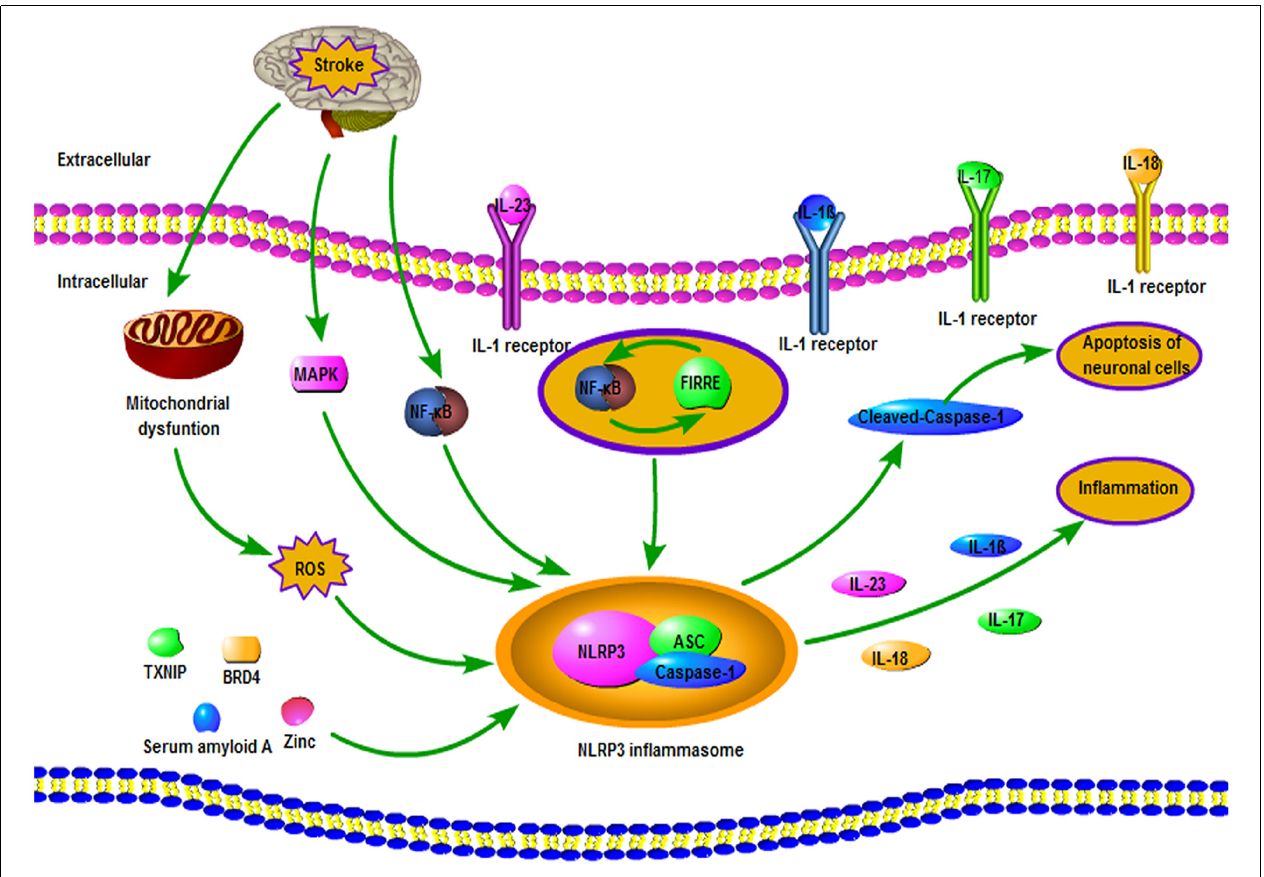
FIGURE 2 | Involvement of the NLRP3 inflammasome in the pathophysiological processes following ischemic stroke. After a stroke, the accumulation of ROS plays an important role in the activation of the NLRP3 inflammasome. Mitogen-activated protein kinase (MAPK) and NF- κ B signaling pathways are regarded as crucial mechanisms for regulating NLRP3 inflammasome. Also, a positive feedback loop formed by functional intergenic repeating RNA element (FIRRE) and NF- κ B promotes the transcription of NLRP3 inflammasome. Furthermore, NLRP3 inflammasome can regulate apoptosis of neuronal cells via cleaved-caspase-1 and promote inflammation by releasing the pro-inflammatory